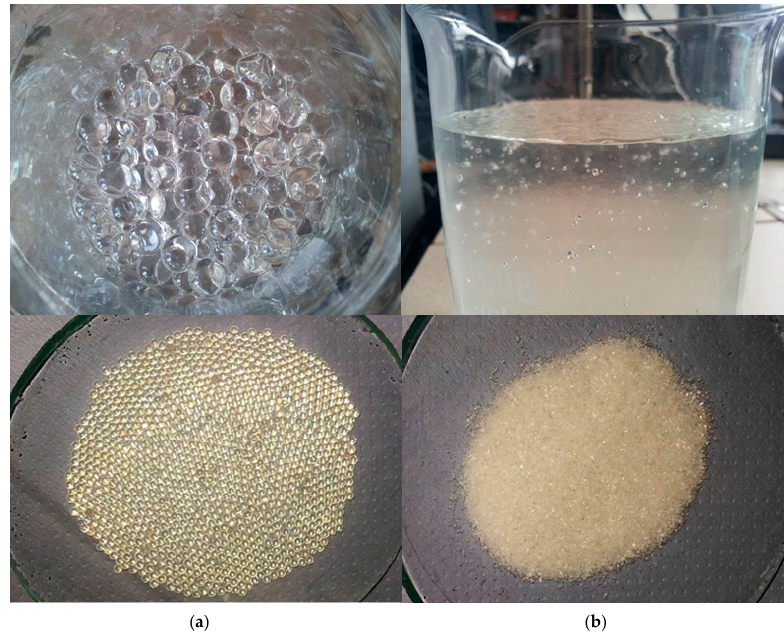
Figure 5. Differences in the water absorption mechanisms of two applied superabsorbent polymers (SAP): ( a ) activated SAP D on the top and non-actiovated in the bottom; ( b ) activated SAP M on the top and non-activated in the bottom.